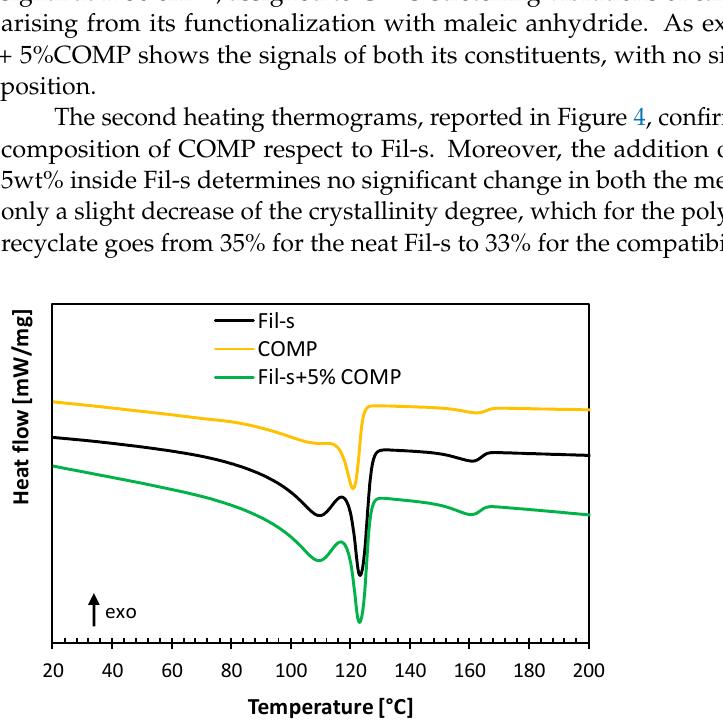
Figure 3. Comparison between the FTIR/ATR spectra of Fil-s, COMP and Fil-s + 5%COMP. In particular, the FT-IR spectra assigned to Fil-s and COMP are very similar. In particular, the compatibilizer shows the typical absorption bands of PE (CH 2 stretching vibrations at 2900–2800 cm − 1 ) and PP (CH 3 scissoring at 1376 cm − 1 ), accompanied by the additional signal at 1730 cm − 1 , assigned to C = O stretching vibrations of carboxylic acid group and arising from its functionalization with maleic anhydride. As expected, the blend Fil-s + 5%COMP shows the signals of both its constituents, with no significant shifts in their position.